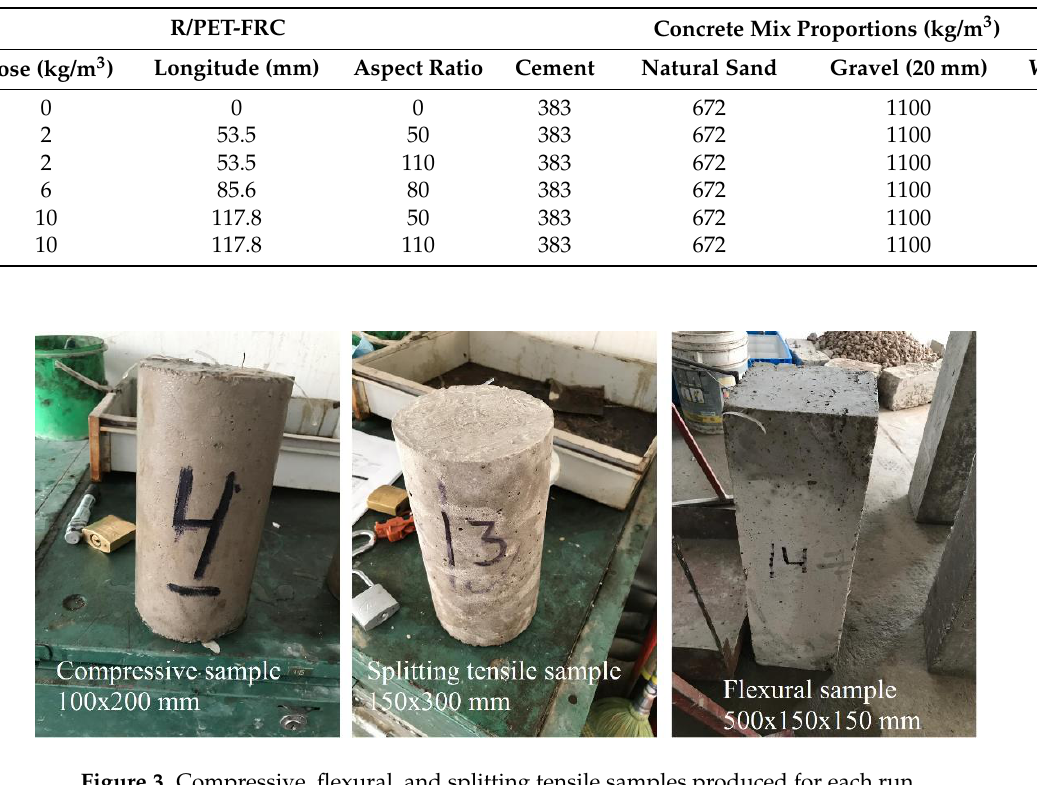
Figure 3. Compressive, flexural, and splitting tensile samples produced for each run.